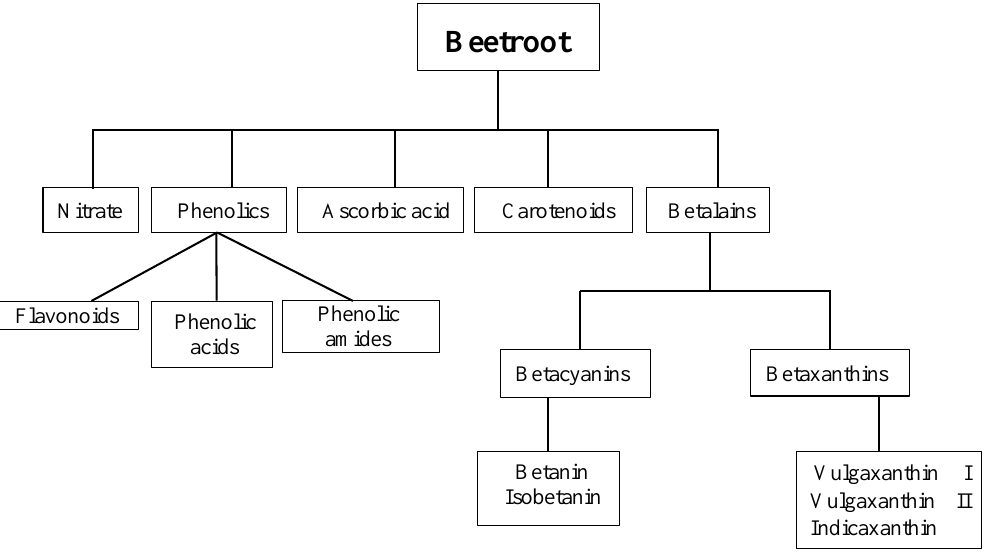
Figure 1. Overview of potentially bioactive compounds in beetroot (based on data from